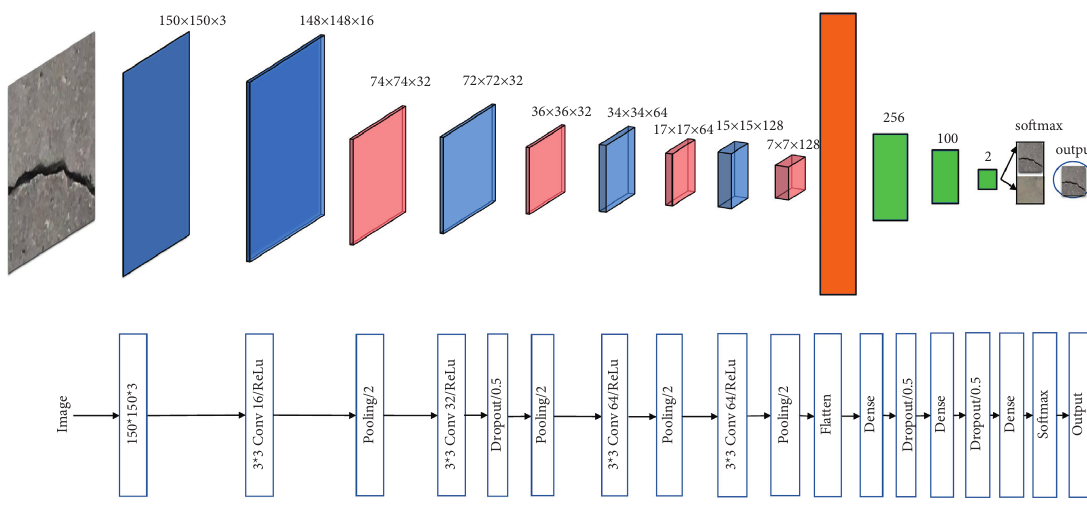
Figure 3: The architecture of Model3. Table 2: Layer dimensions and